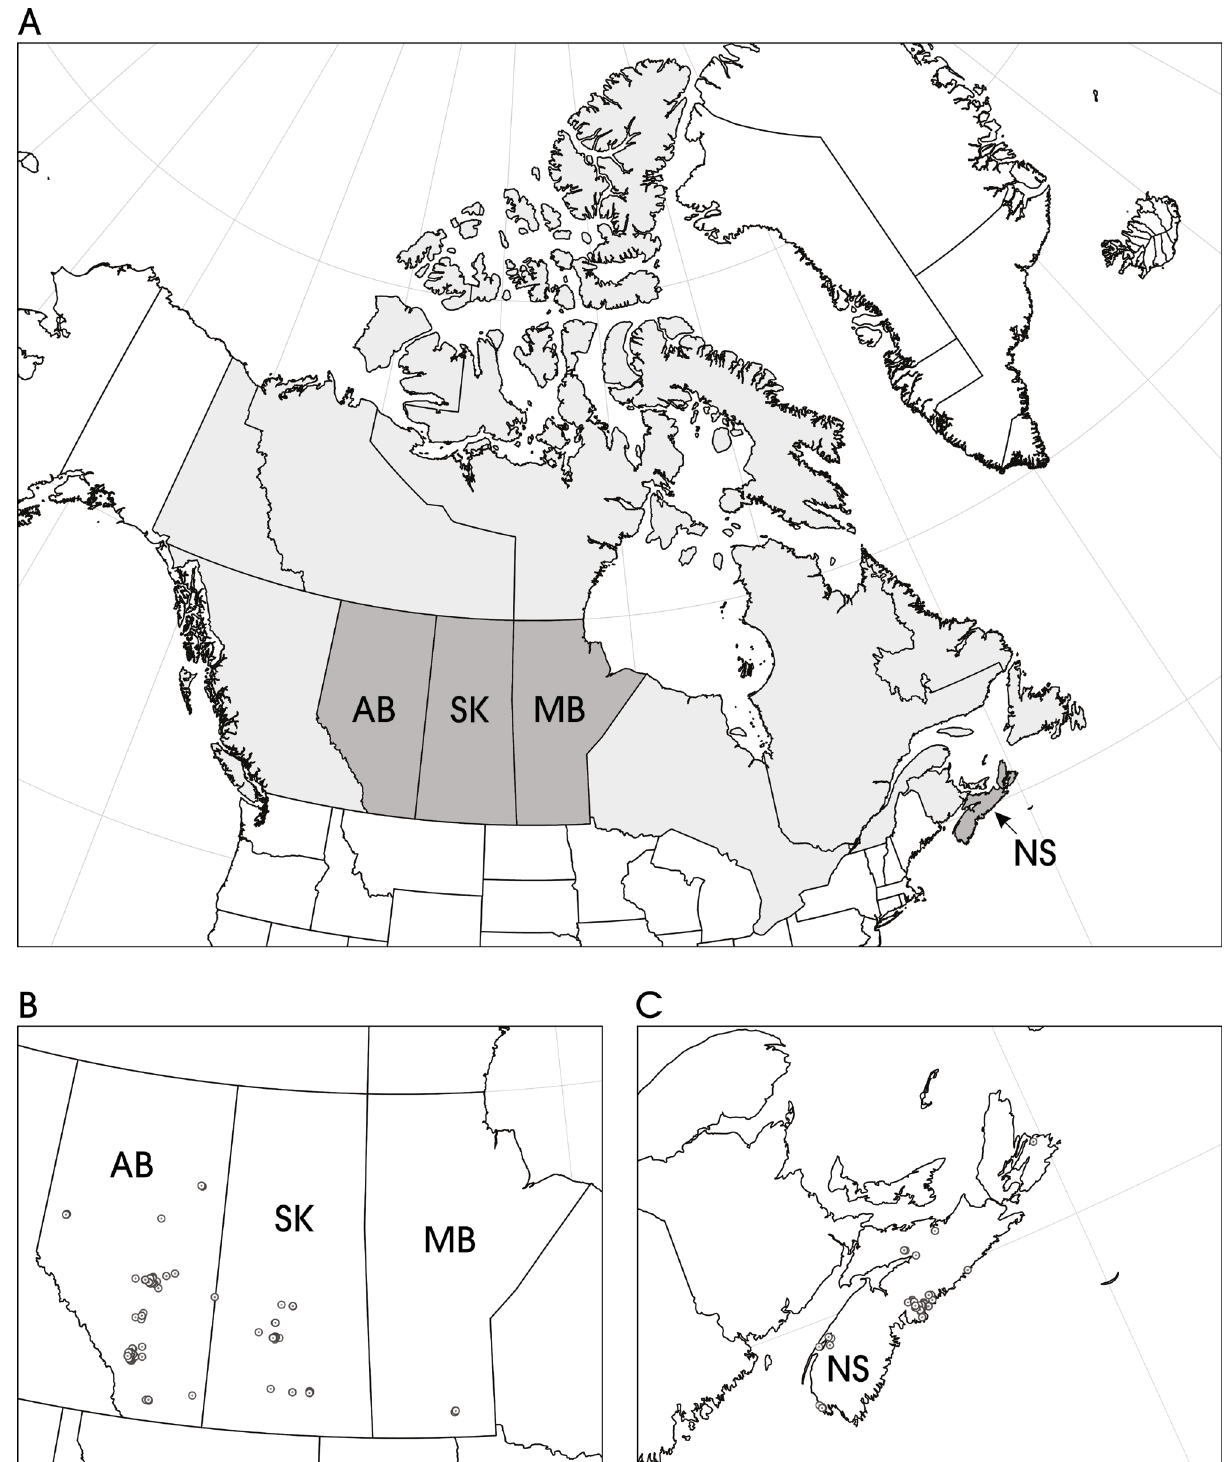
Figure 2. A, Map of Canada (light gray) with focal provinces in this study shown in dark gray. B, Map of Canadian prairie provinces of Alberta (AB), Saskatchewan (SK), and Manitoba (MB), with dots showing locations of sellers placing advertisements for crayfish on Kijiji. Most dots concentrate around cities such as Calgary and Edmonton (AB), Regina and Saskatoon (SK), and Winnipeg (MB). C, Canadian Atlantic province of Nova Scotia (NS), with dots showing locations of sellers placing advertisements for crayfish on Kijiji. Most dots are near the city of